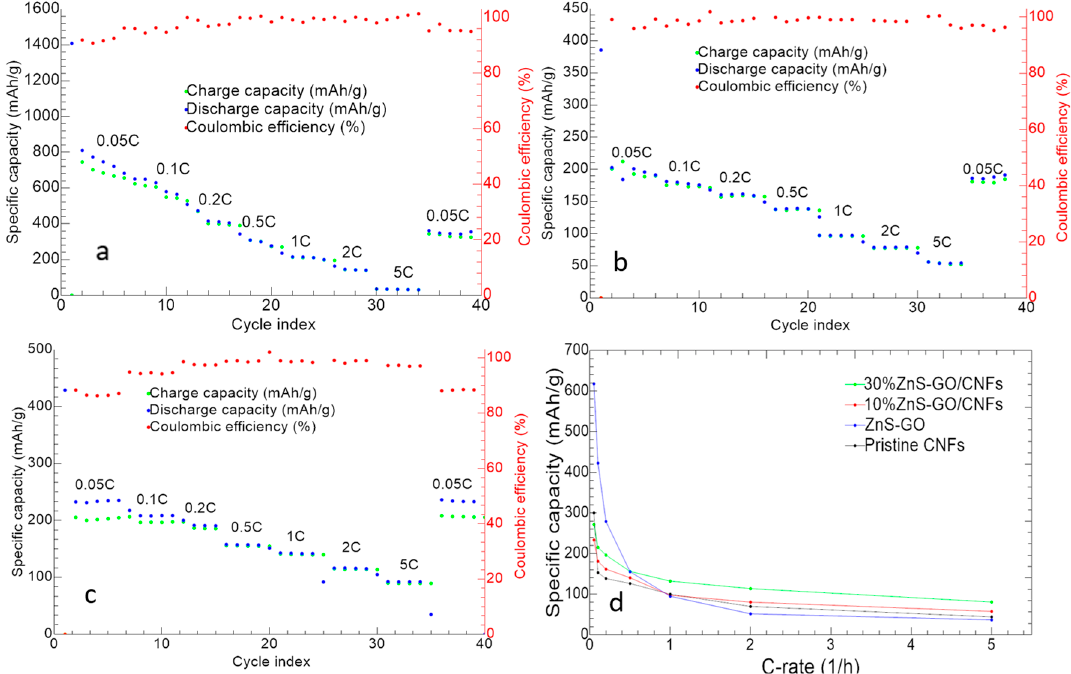
Figure 11. Charge/discharge cycles at different C-rates of ( a ) ZnS–GO, ( b ) 10%ZnS–GO/CNF and ( c ) 30%ZnS–GO/CNF samples. ( d ) Samples’ capacity vs. C-rates. Charge (green), discharge (blue) and coulombic e ffi ciency (red).